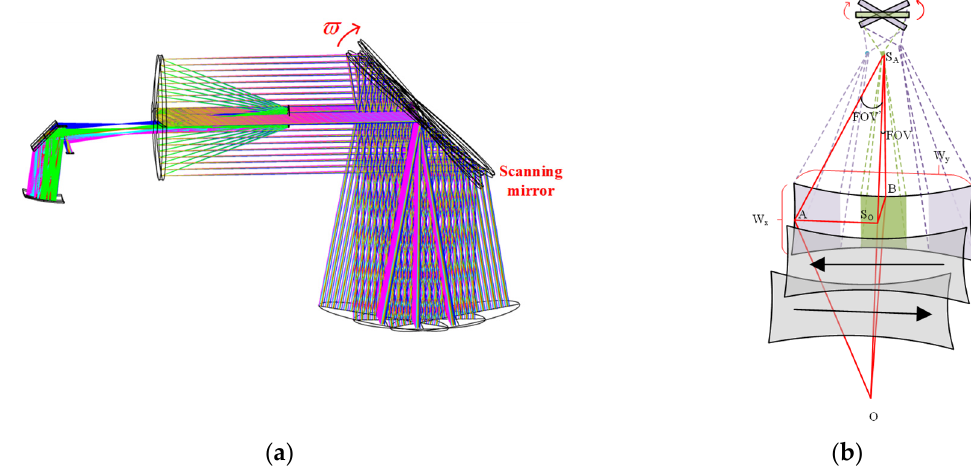
Figure 2. Wide-swath whiskbroom imaging with the swing mirror: ( a ) Optical system of scanning imaging along the coastal zone; ( b ) The imaging trajectory of the swing mirror.